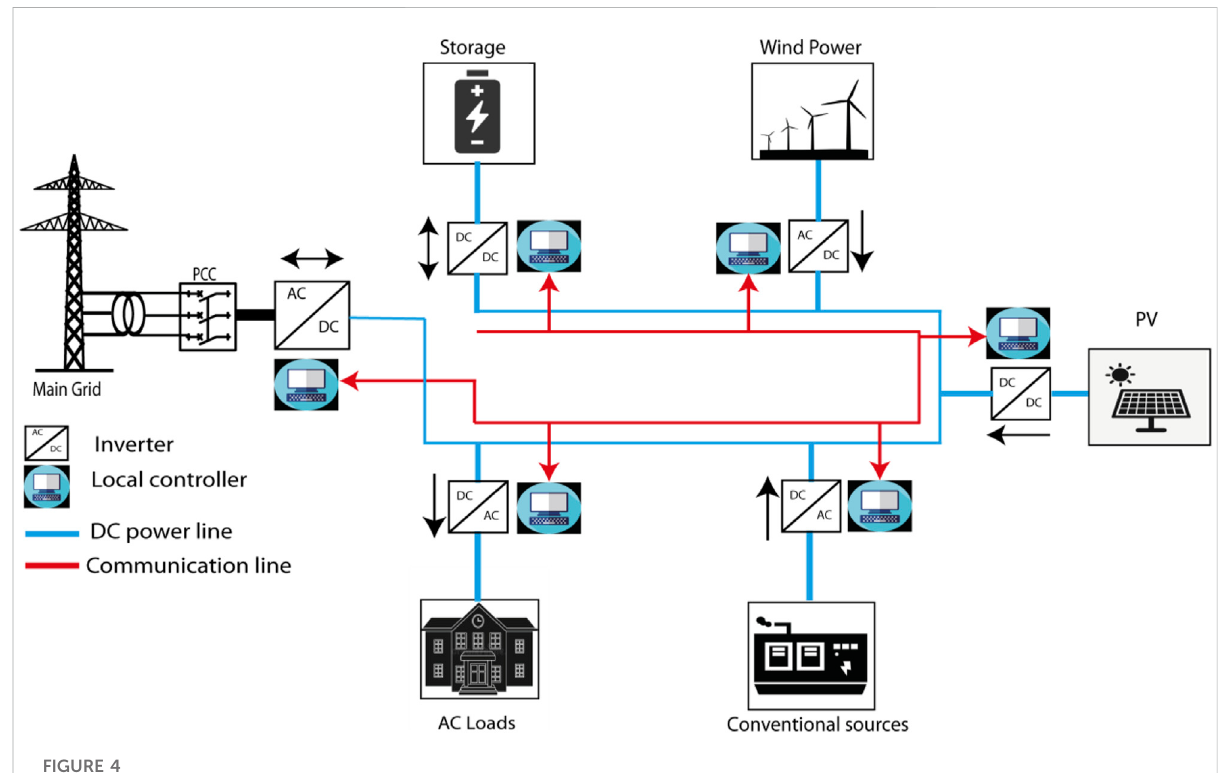
FIGURE 4 Architecture of decentralized